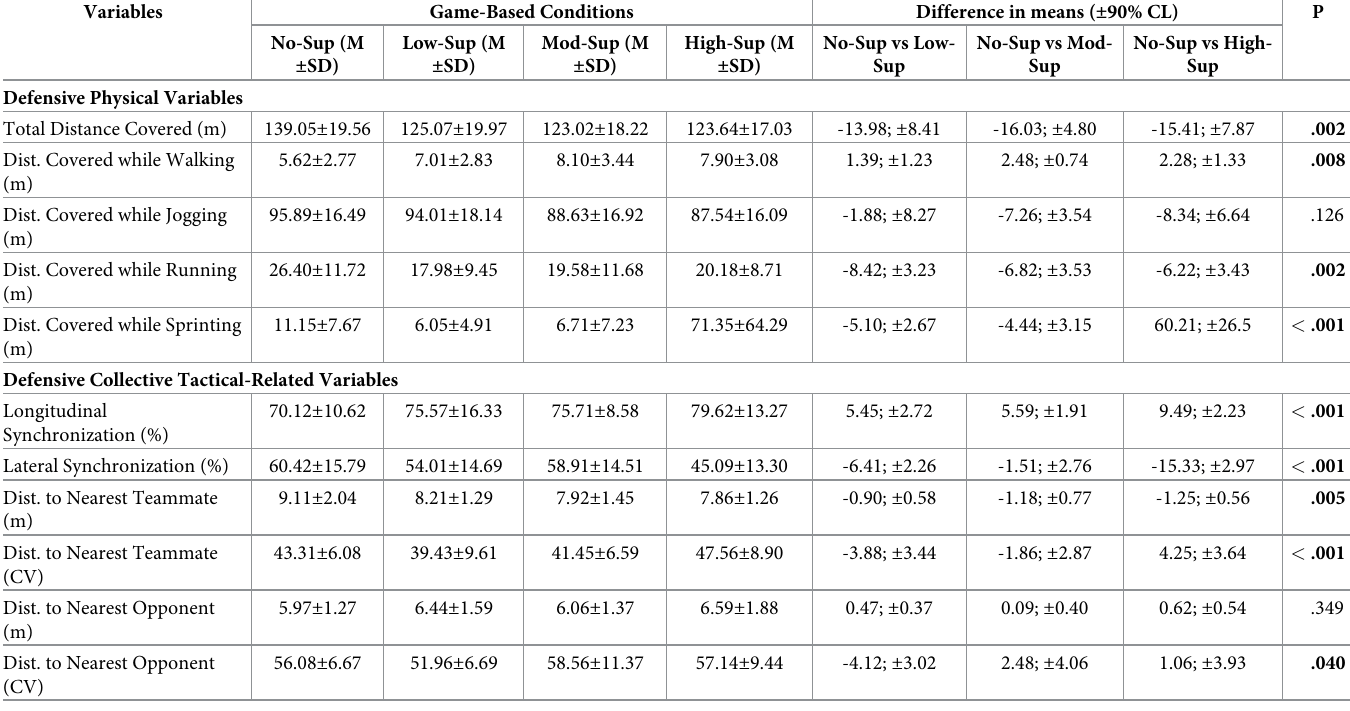
Table 2. Descriptive and statistical analysis for physical and collective tactical-related variables when playing in superiority (cooperative-perspective) during the defensive phase.